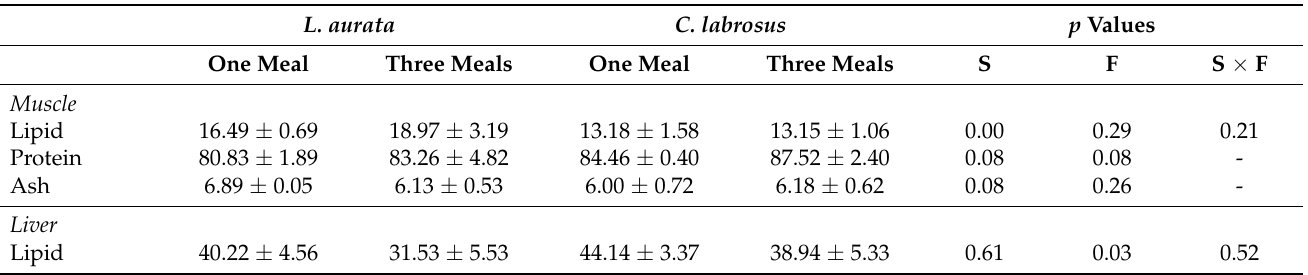
Table 4. Proximal composition (% of dry weight) of the muscle and liver expressed by species (S) and feeding frequency (F) (n = 9).